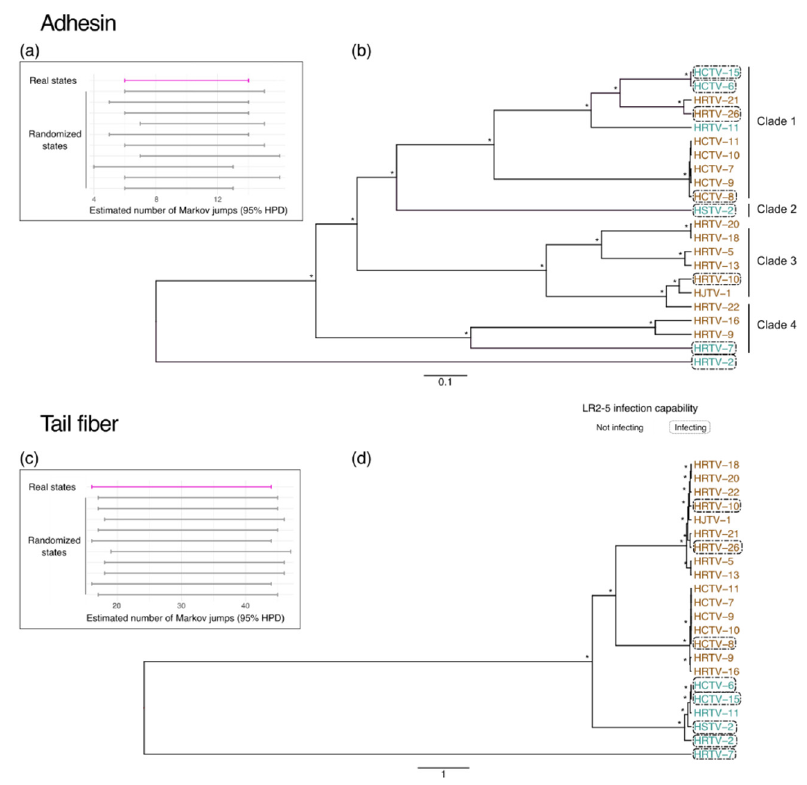
Figure 5. Comparison of the adhesin and tail fiber gene sequence phylogenies to the ability of viruses to infect LR2-5. ( a , c ) Distribution of Markov jumps (95% HPD) for (i) real states (pink) and (ii) randomized states (grey). ( b , d ) Bayesian maximum clade credibility tree with discrete trait reconstruction based on adhesin or tail fiber gene sequences, respectively. Asterisk indicates node posterior probabilities higher than 0.8, and viruses in the boxes can infect LR2-5. Color code indicates the genus; blue Mincapvirus , brown Haloferacalesvirus .